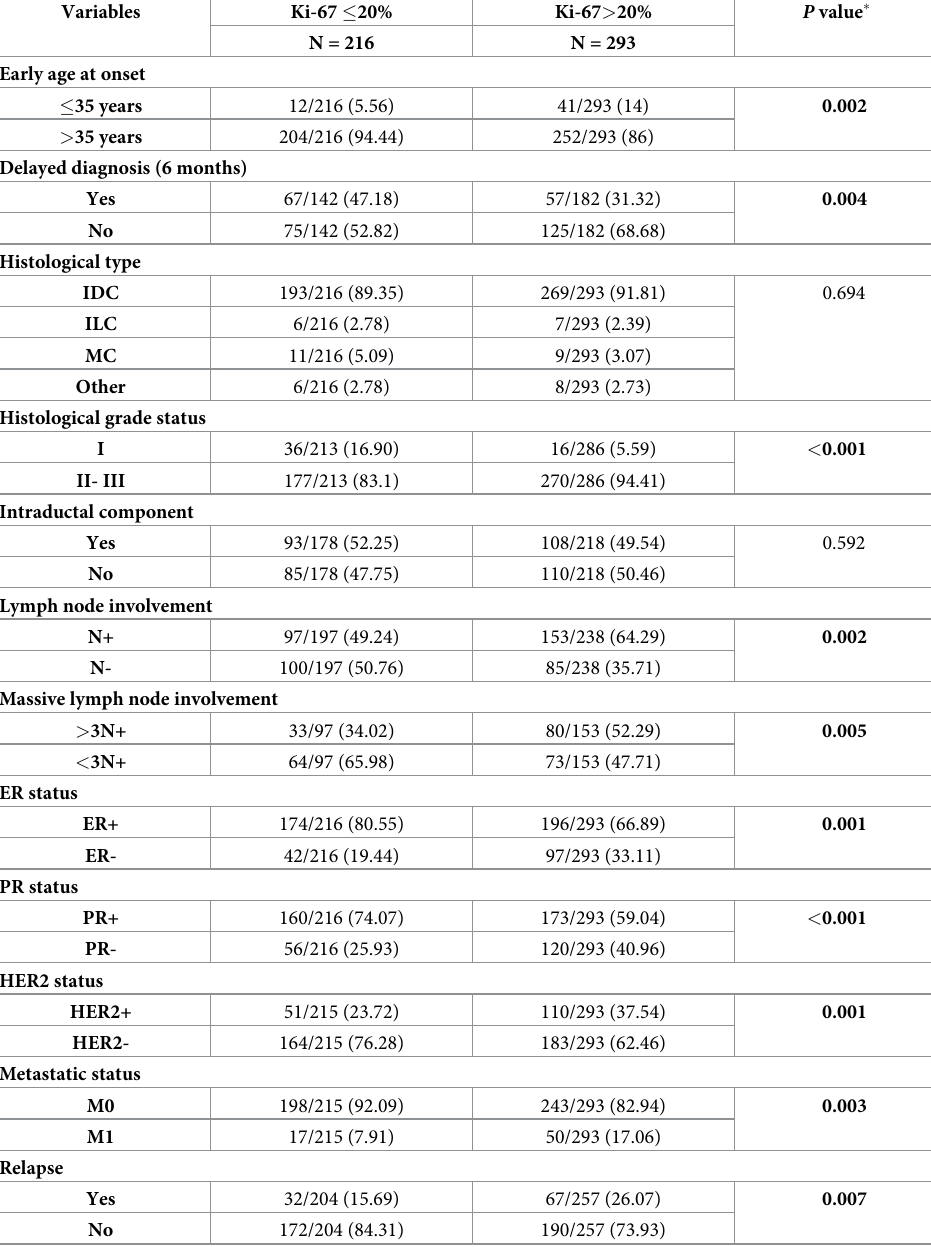
Table 3. Correlation between Ki-67 expression and clinicopathological features in breast cancer